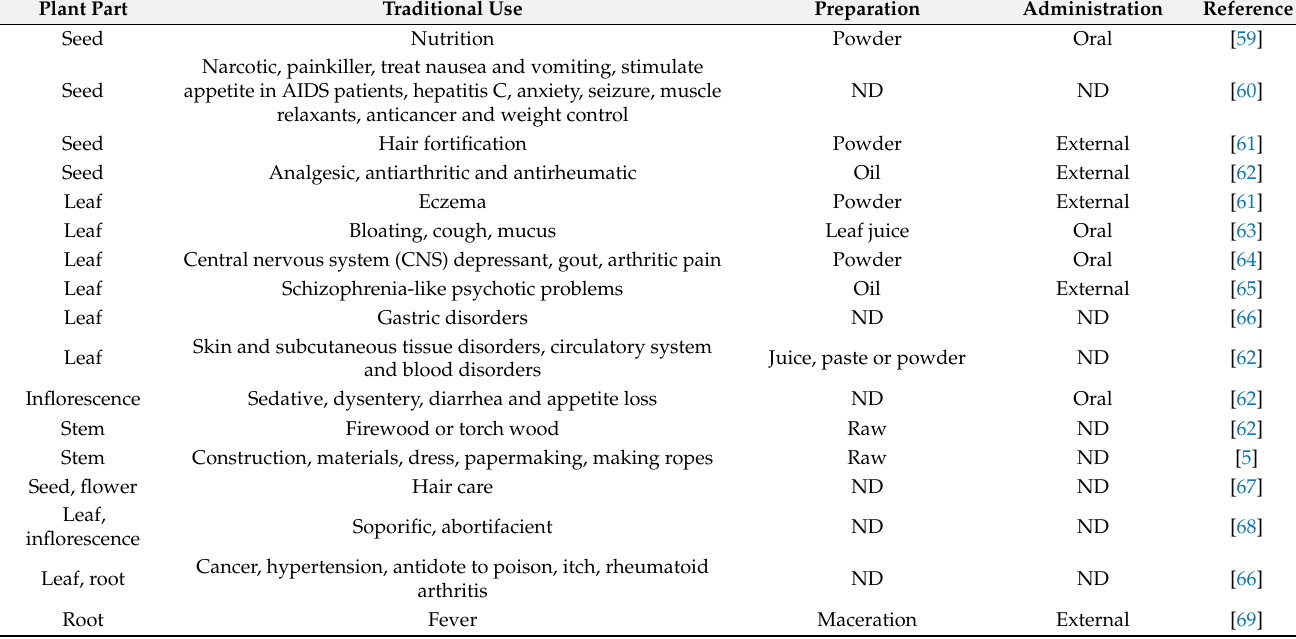
Table 1. Traditional uses of different parts of Cannabis sativa